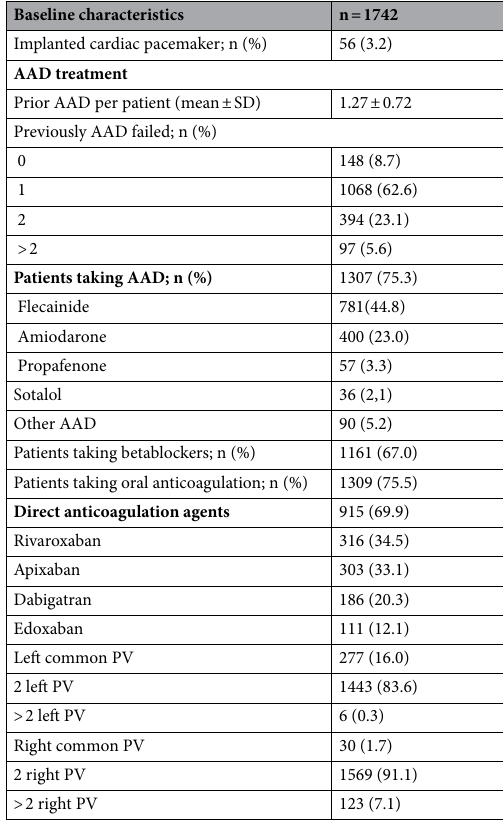
Table 1. Clinical baseline characteristics. Percentage values have been calculated for valid responses and on the total of the sample. Quantitative data are the mean ± standard deviation. BMI body mass index, AF atrial fibrillation, TIA transient ischemic attack, CHA 2 DS 2 VASc 2 Score for AF and stroke risk, AHS apnea–hypopnea syndrome, LVEF left ventricular ejection fraction, AAD antiarrhythmic drugs, PV pulmonary veins, LCT left common trunk, RCT right common trunk. *High level of exercise defined as > 300